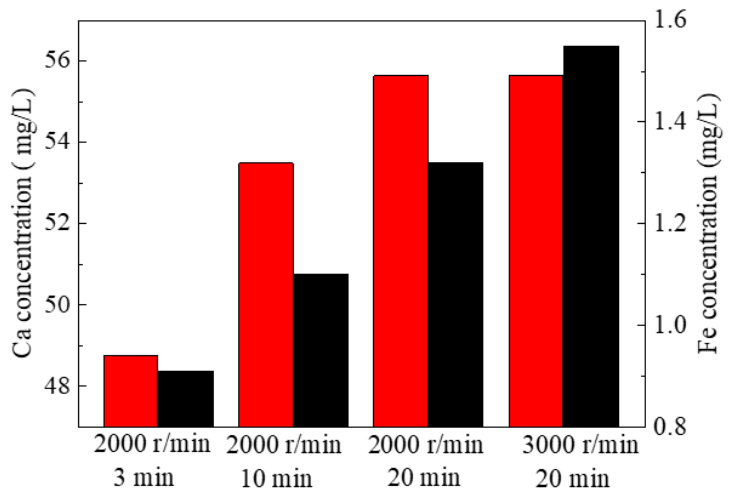
Figure 13. Ca and Fe concentrations of the pulp water under different stirring conditions.